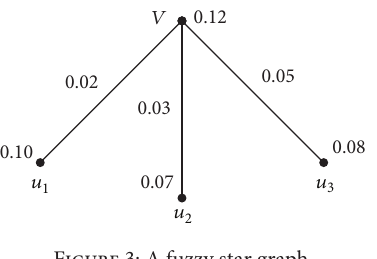
Figure 3: A fuzzy star